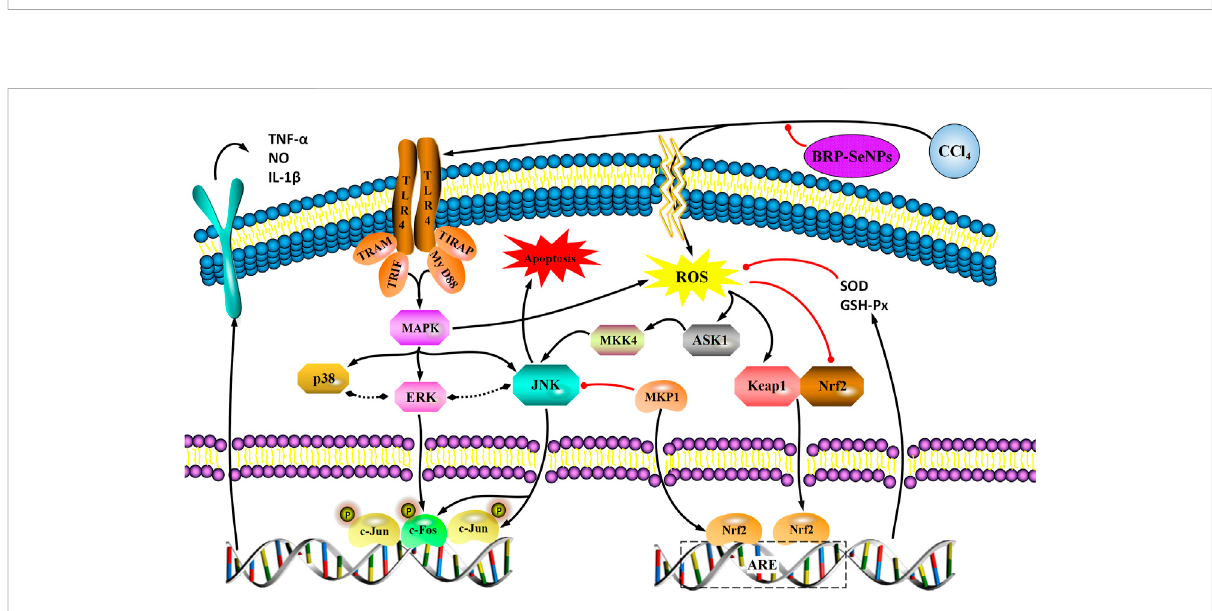
AproposedmechanismforthehepatoprotectiveeffectofBRP-SeNPsonCCl 4 -inducedliverinjury invivo .Blackarrowrepresentstheactivation and red line the